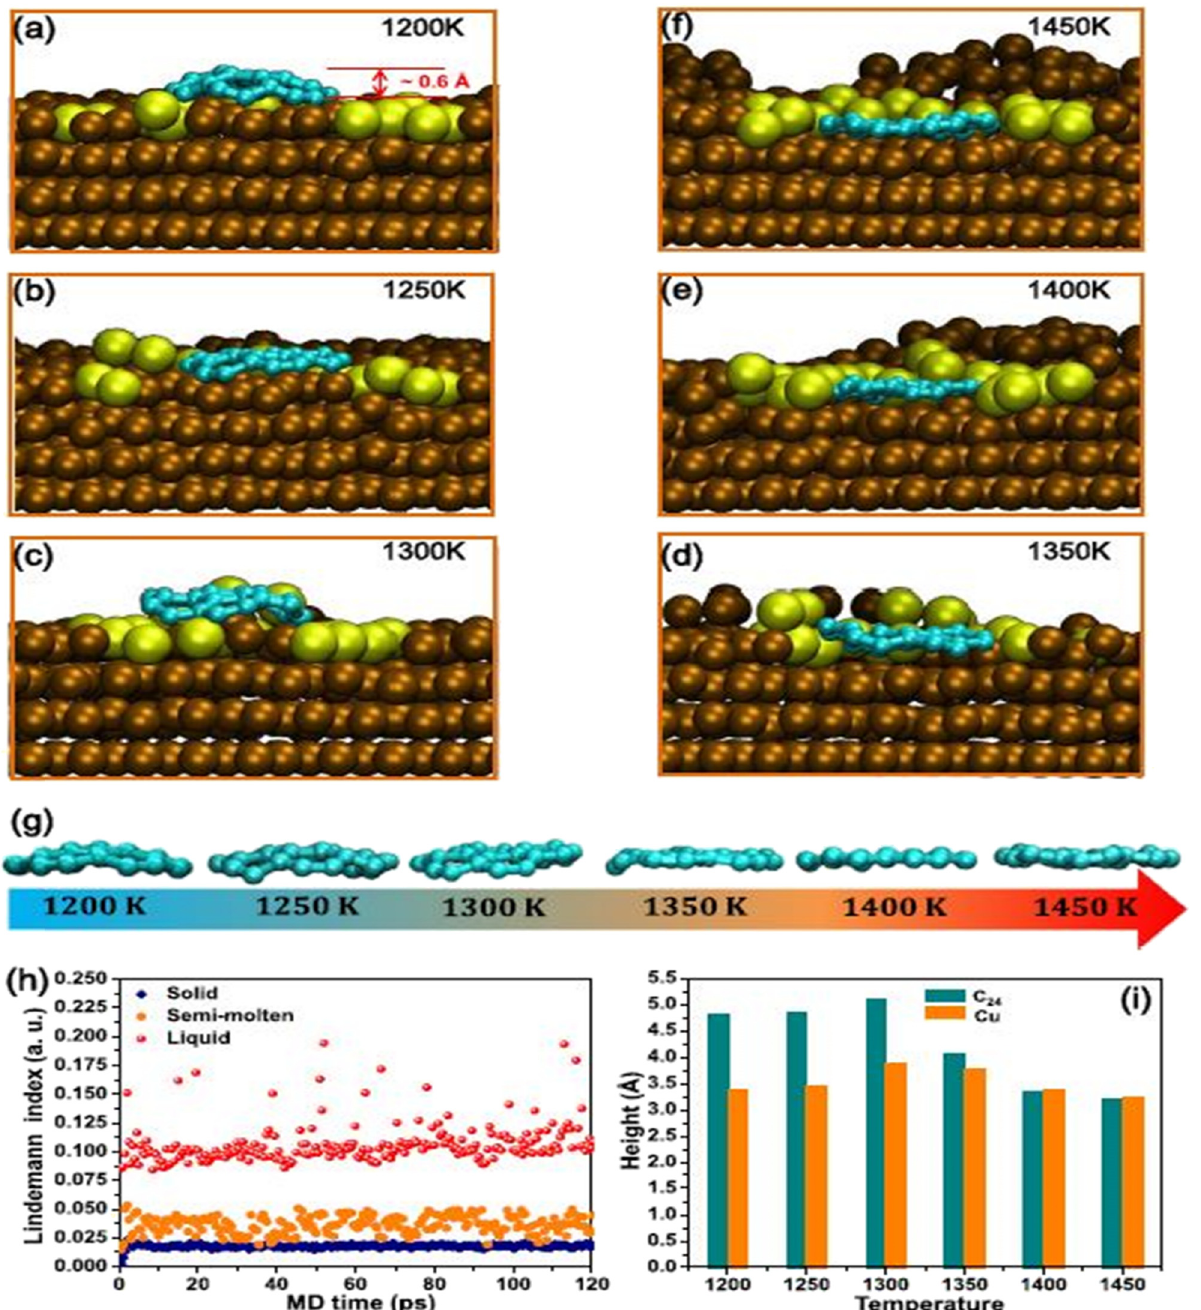
Figure 13: C 24 sinking on the surface of Cu ( 111 ) e at various temperatures. ( a ) – ( f ) C 24 cross - sections on the surface of Cu ( 111 ) MD simulations after 120 ps at temperatures of 1,200, 1,250, 1,300, 1,350, 1,400 and 1,450 K, respectively. Copper atoms that are close to the boundary of C 24 are shown in yellow. ( g ) The C 24 pro fi les that were extracted at the di ff erent temperatures ( a ) – ( f ) . The ochre and cyan balls show copper and carbon atoms, respectively. ( h ) The computed Lindemann index of copper substrates in solid, semi - molten, and liquid forms. ( i ) Temperature - dependent average heights of C24 and its neighbouring atoms during the fi nal 20 ps [ 119 ]